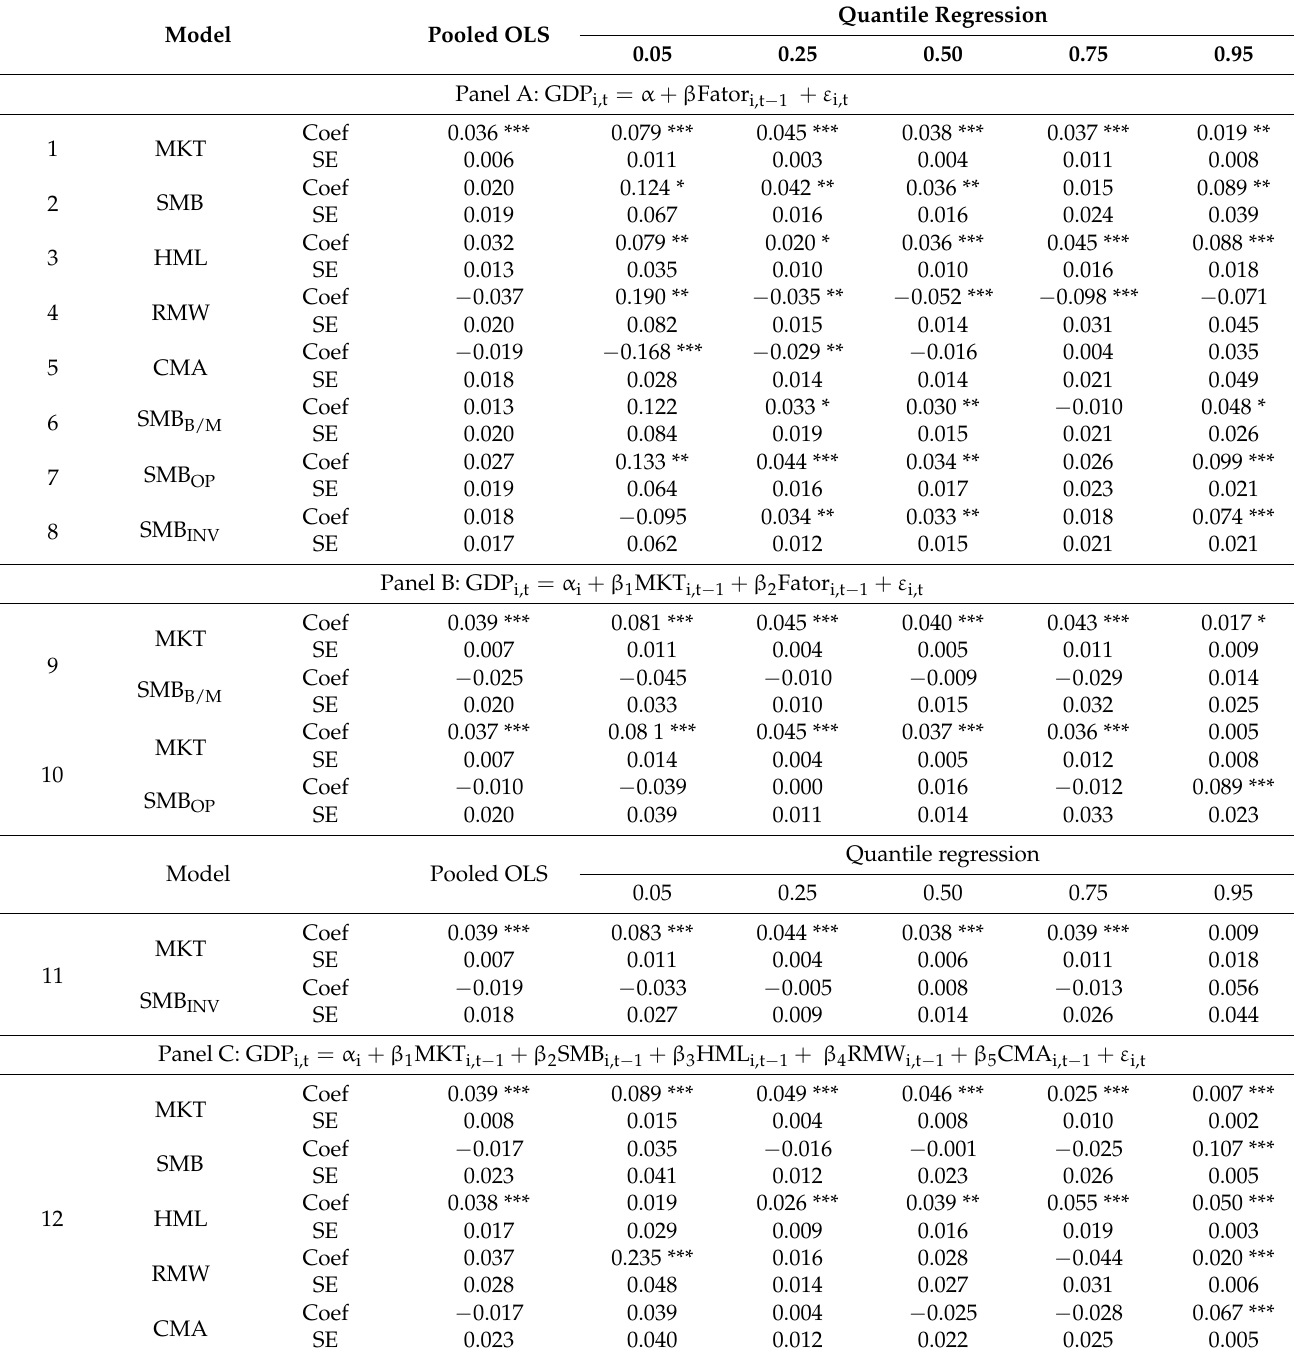
Table 4. Simple and multiple regression